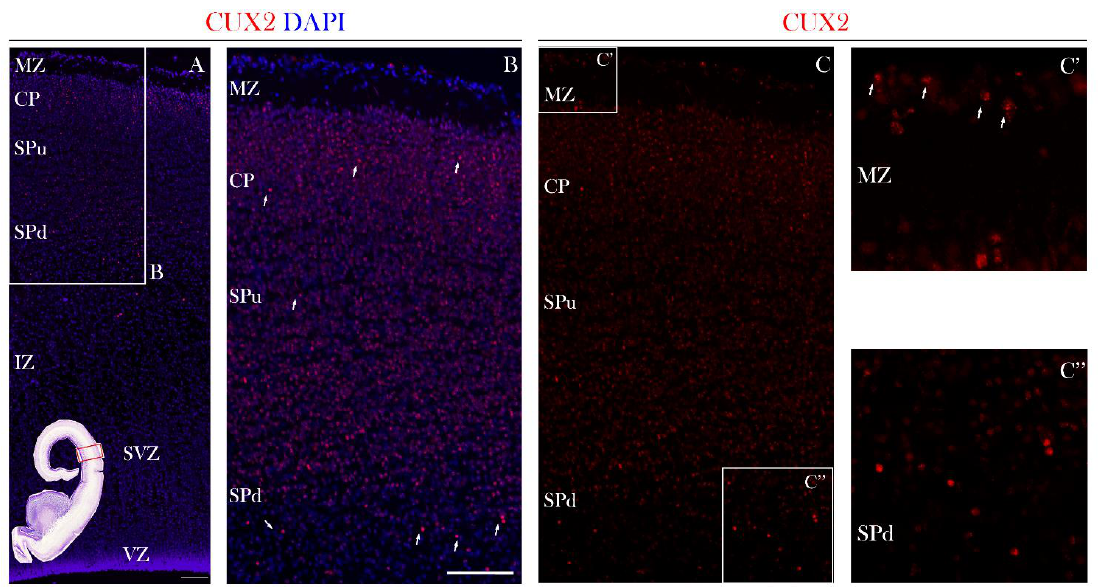
Figure 3. CUX2 is expressed in the MZ, superficial CP, and both upper and deep SP during the SP formation phase at 13 PCW. ( A,B,C ) Representative images of coronal section through the prospective dorsolateral frontal cortex (indicated by box in the Nissl stained complete scan of the coronal section in the lower left corner), was immunostained for CUX2 (red) and DAPI (blue) during formation of the SP phase at 13 PCW ( C ) CUX2+ nuclei (white arrows) were found to be scattered in the MZ ( C’ ), superficial CP, upper SP (SPu; SP in formation), and had strong reactivity in the deep subplate (SPd) ( C’’ ).